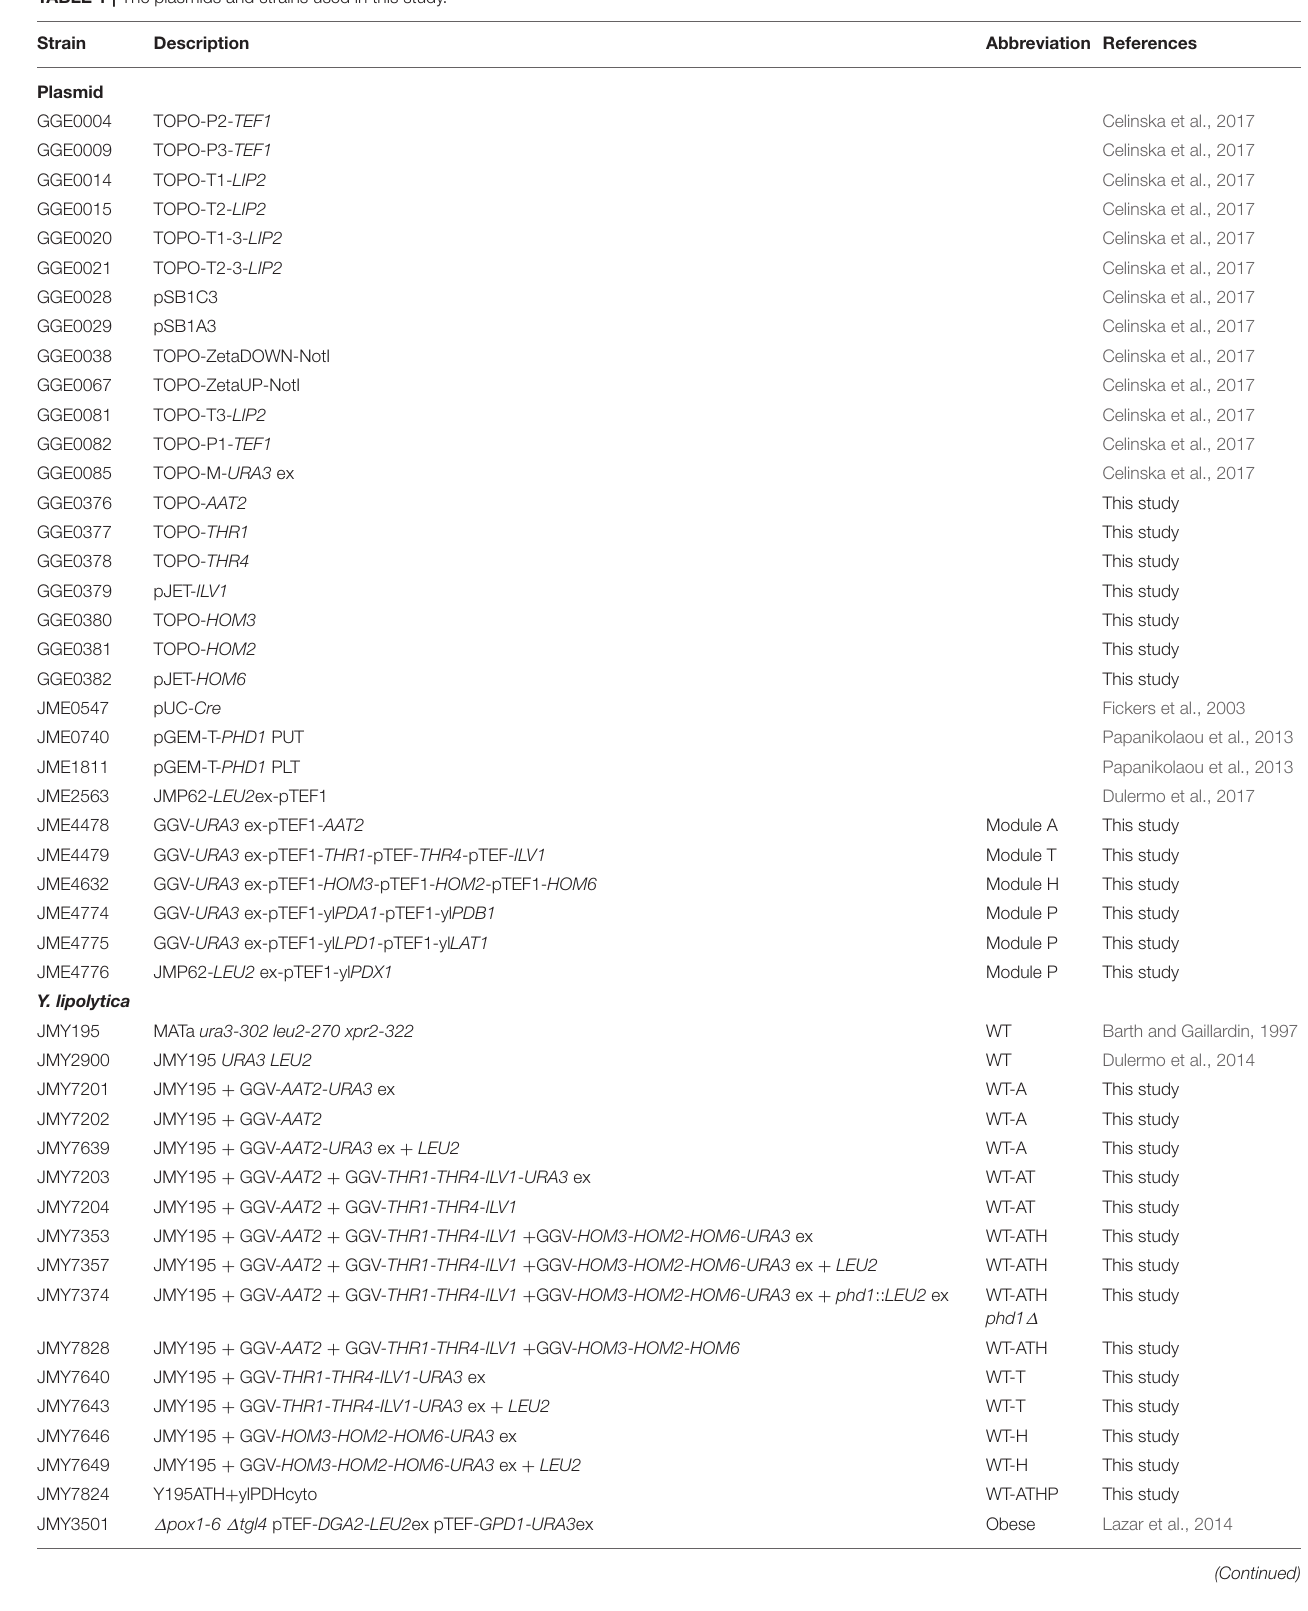
TABLE 1 | The plasmids and strains used in this study. Strain